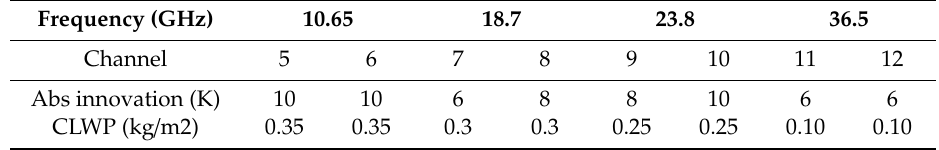
Table 1. Quality-control thresholds.